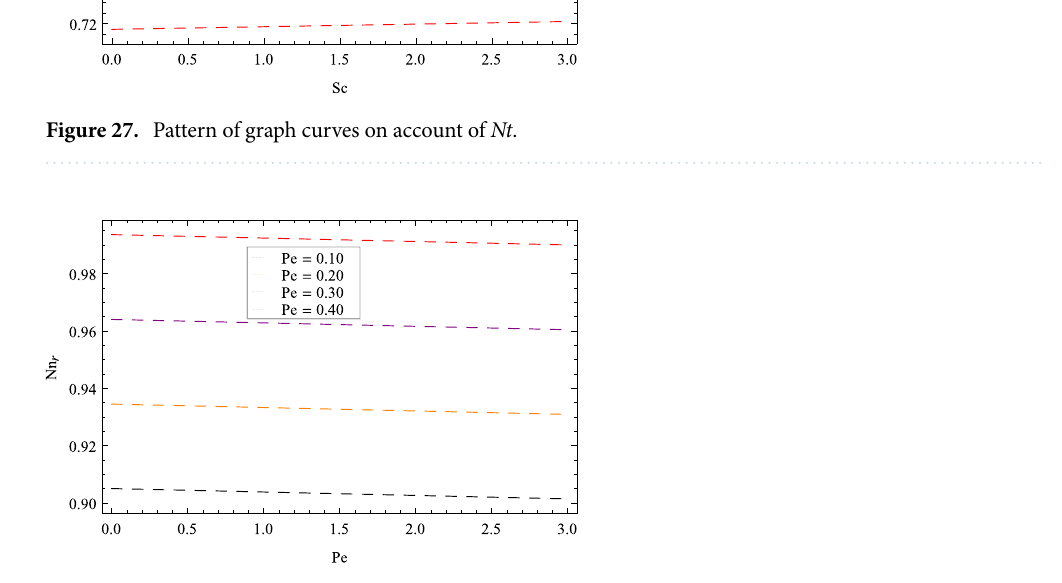
Figure 28. Pattern of graph curves on account of Pe